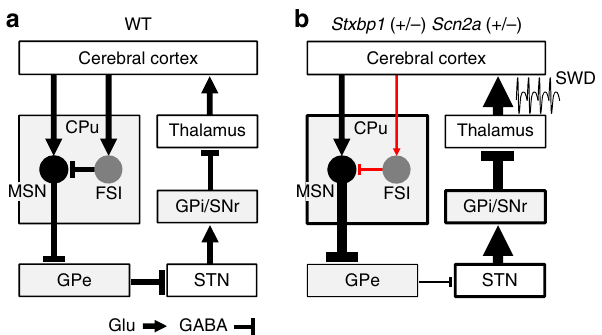
Fig. 9 A striatal circuit model for epilepsy in Stxbp1 + / − and Scn2a + / − mice. a Canonical neural circuit of the indirect pathway in WT mice. b Hypothetical circuit for absence seizures in Stxbp1 + / − and Scn2a + / − mice. Thicker and thinner lines indicate increased and decreased neural transmissions,